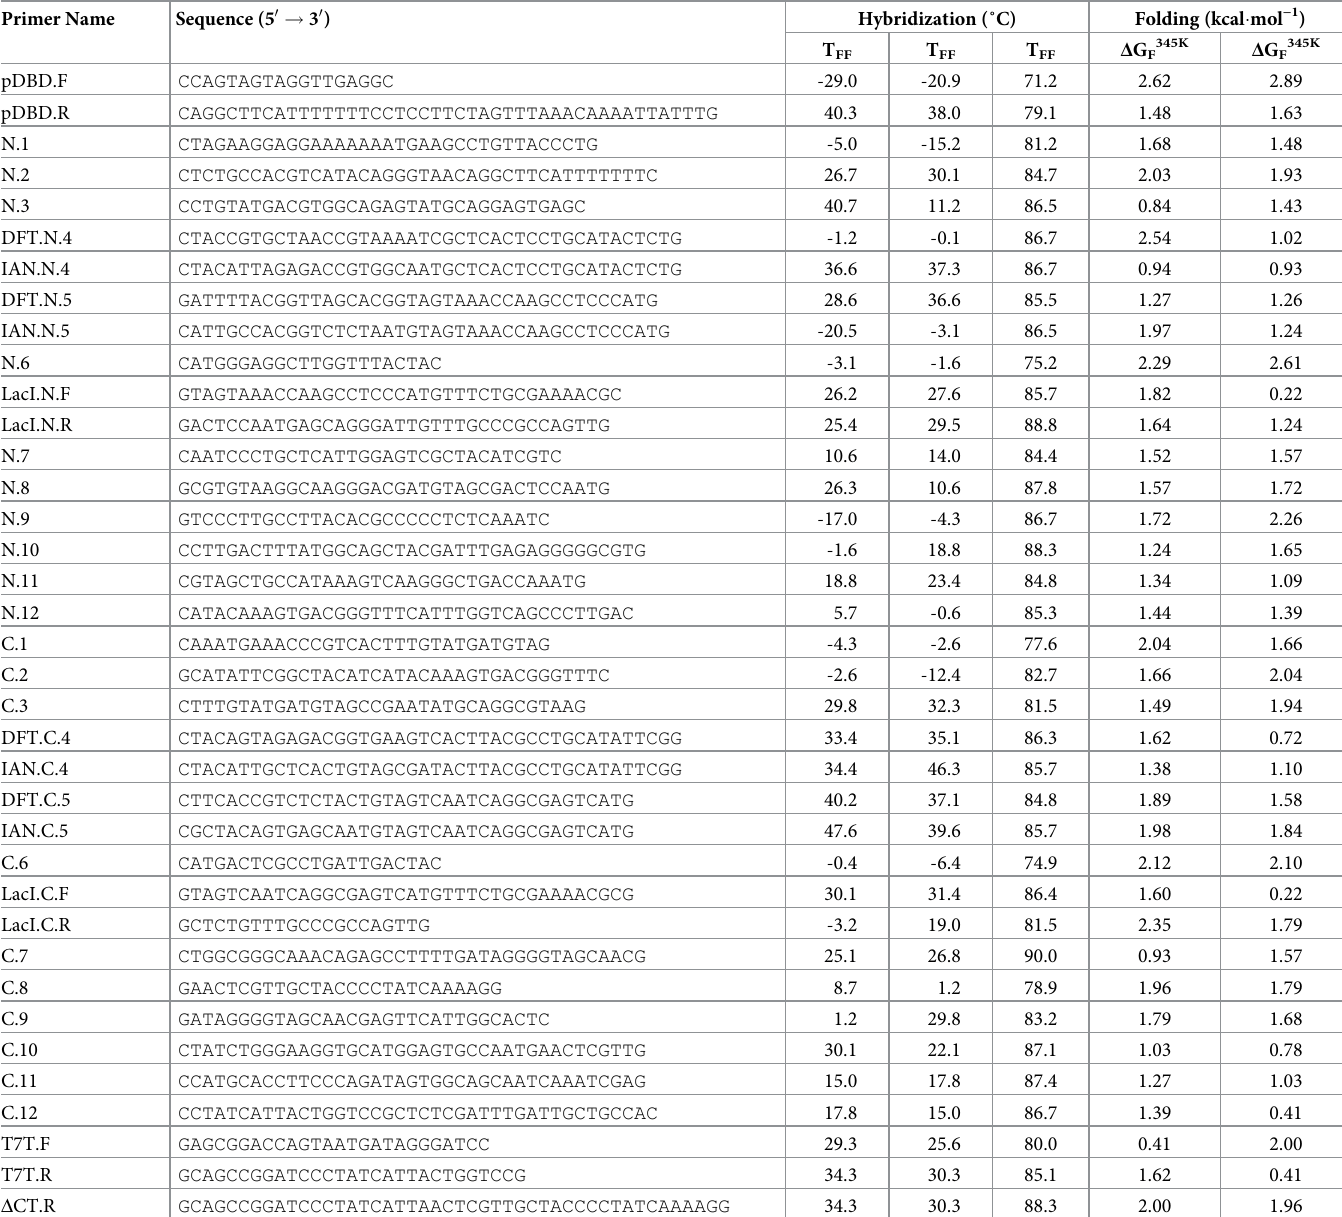
Table 1. Assembly PCR oligonucleotide primers for the TReSR designed tandem repeat repressor. Primer